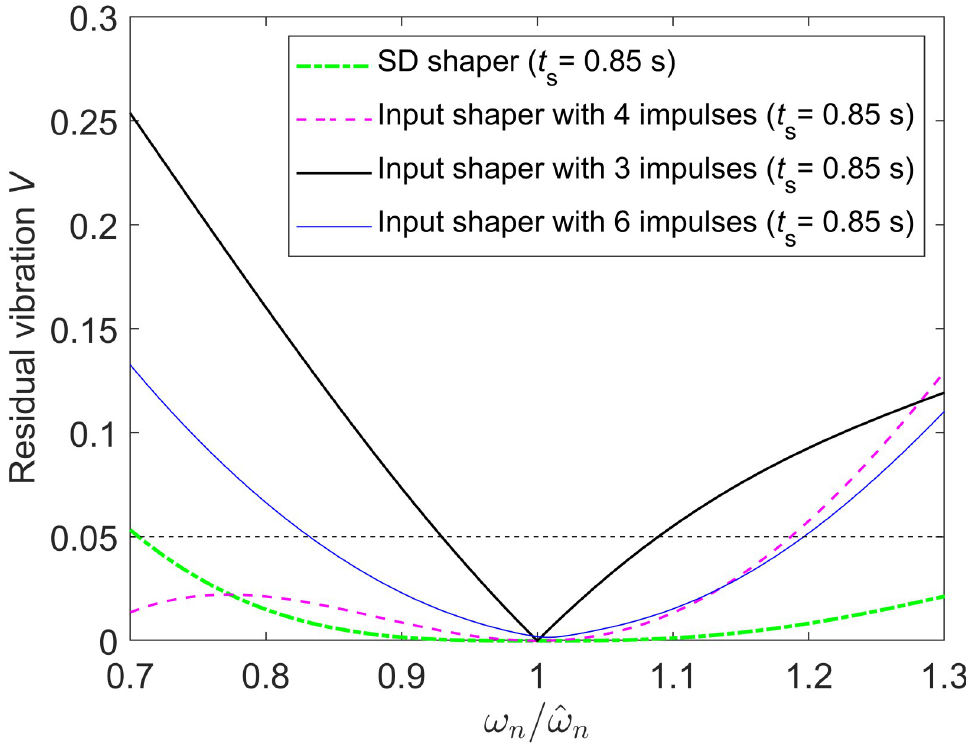
Fig 8. Sensitivity curves of the SD shaper with five impulses and input shapers with three, four or six impulses for the case with the shaping time t = 0.85 s for an underdamped system with ^ ω s five impulses is more robust to modeling errors than the input shaper with three, four or six impulses for t s = 0.85 s.